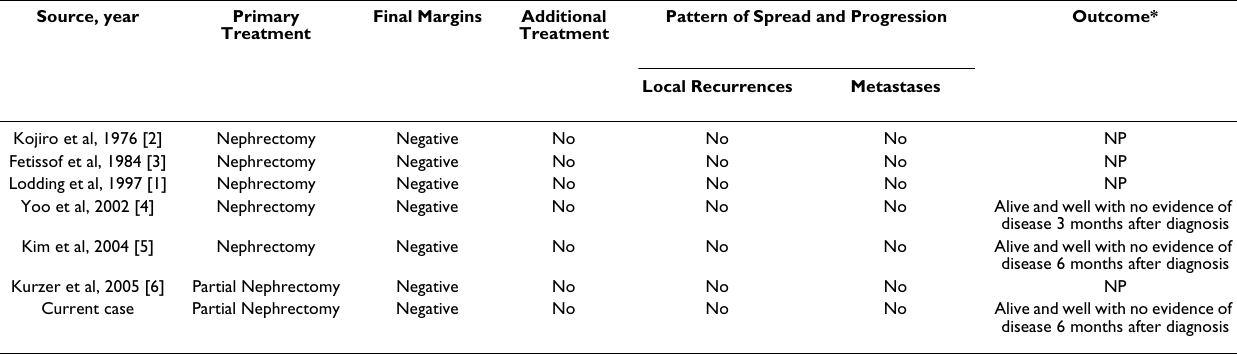
Table 3: Treatment, follow-up and prognosis for primary carcinoid tumor arising within mature teratoma of the kidney Source,